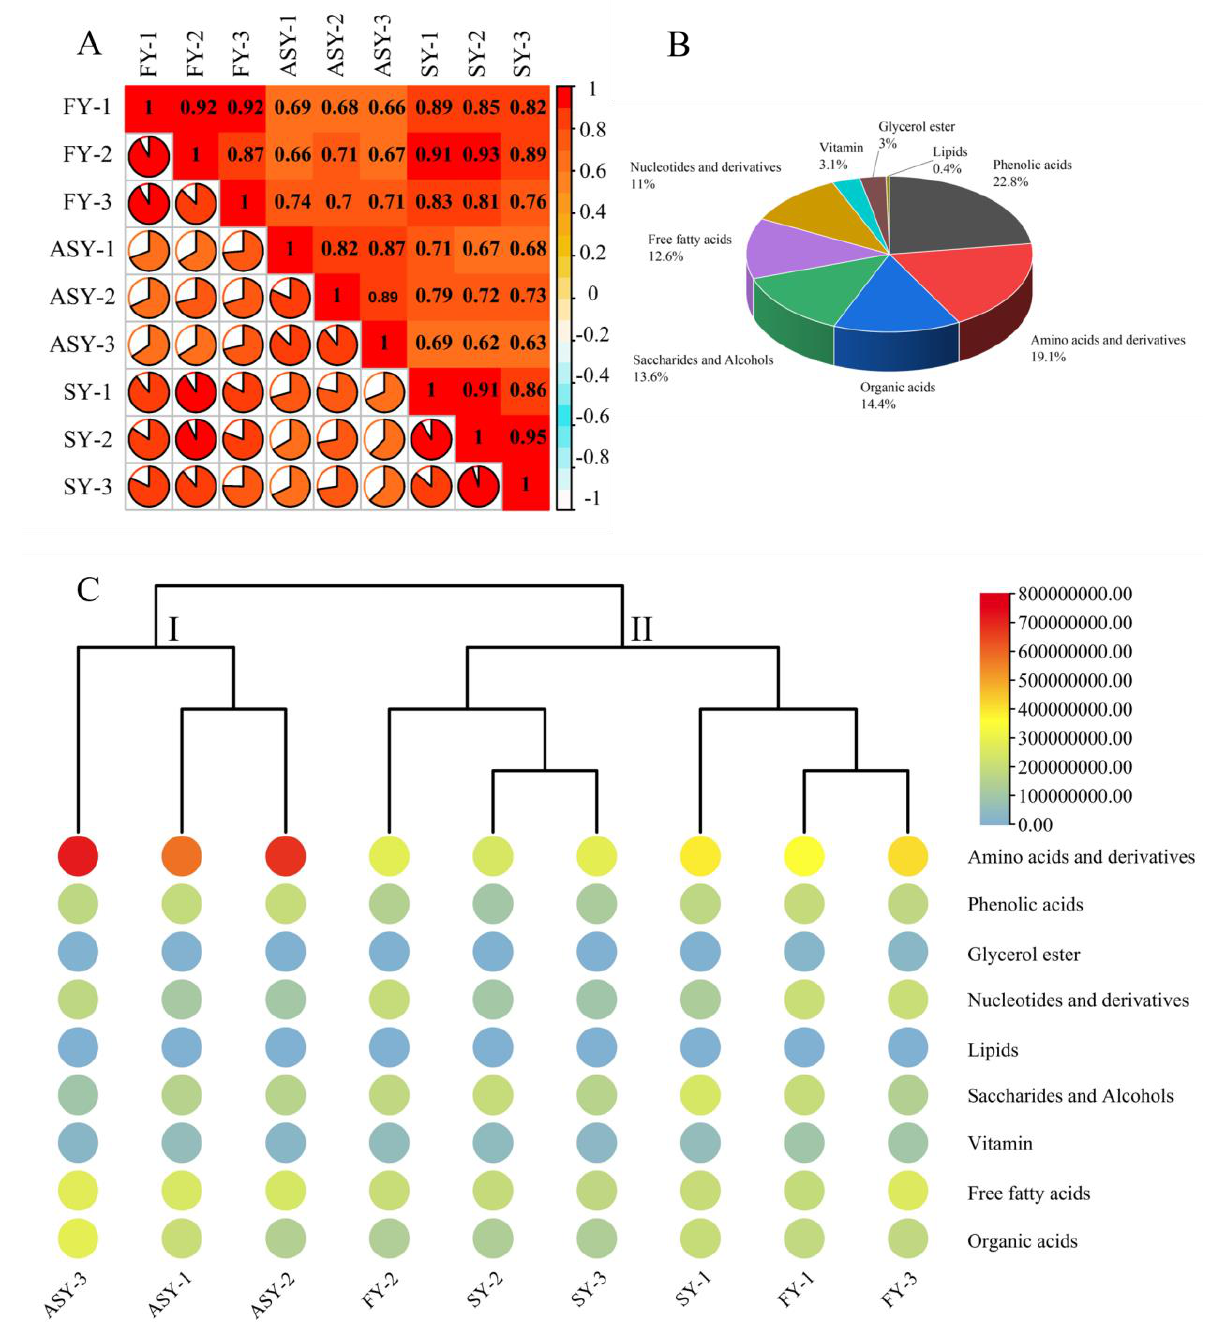
Figure 3. The metabolomics data reveal the change in primary metabolites among three phenotypes of F. cirrhosa . ( A ) Correlation analysis; ( B ) category of metabolites; ( C ) heatmap of metabolites. FY: four-year samples. SY: six-year samples. ASY: aberrant six-year